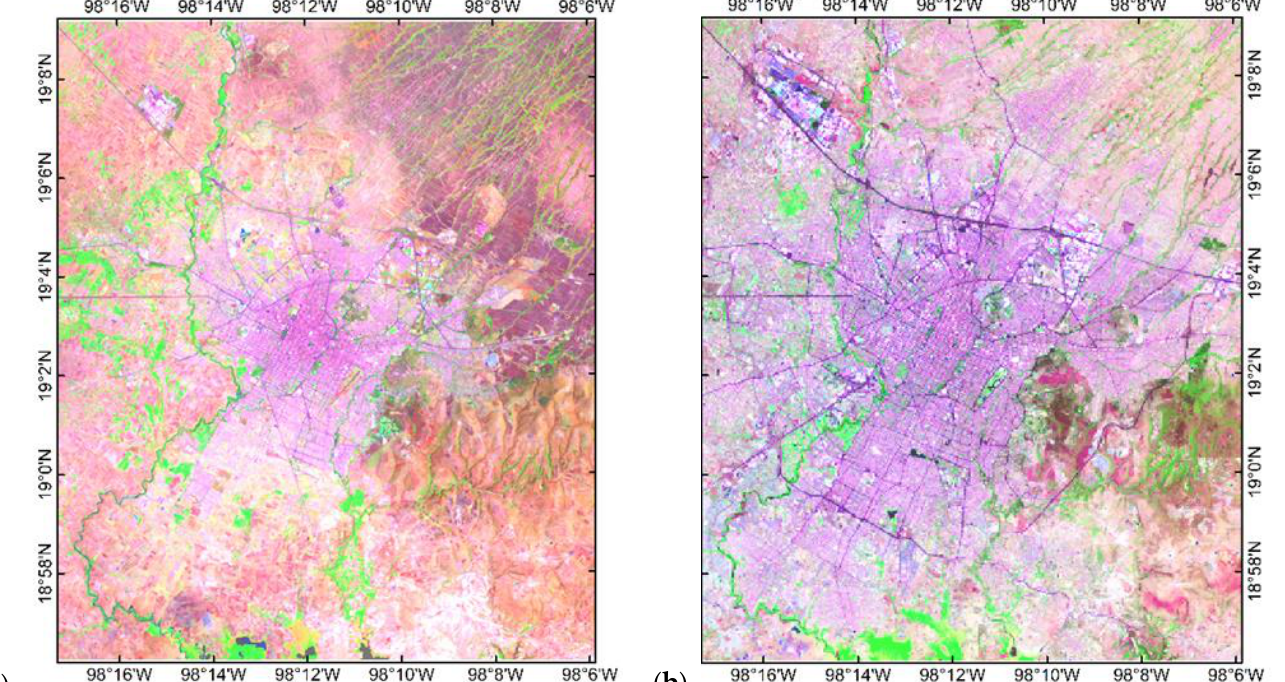
Figure 3. A comparison of urban extent from 3 May 1986 in ( a ) using Landsat 5 data, RGB band combination (5,4,3), and in ( b ) for 14 May 2019 data using Landsat 8, band combination (6,5,4).